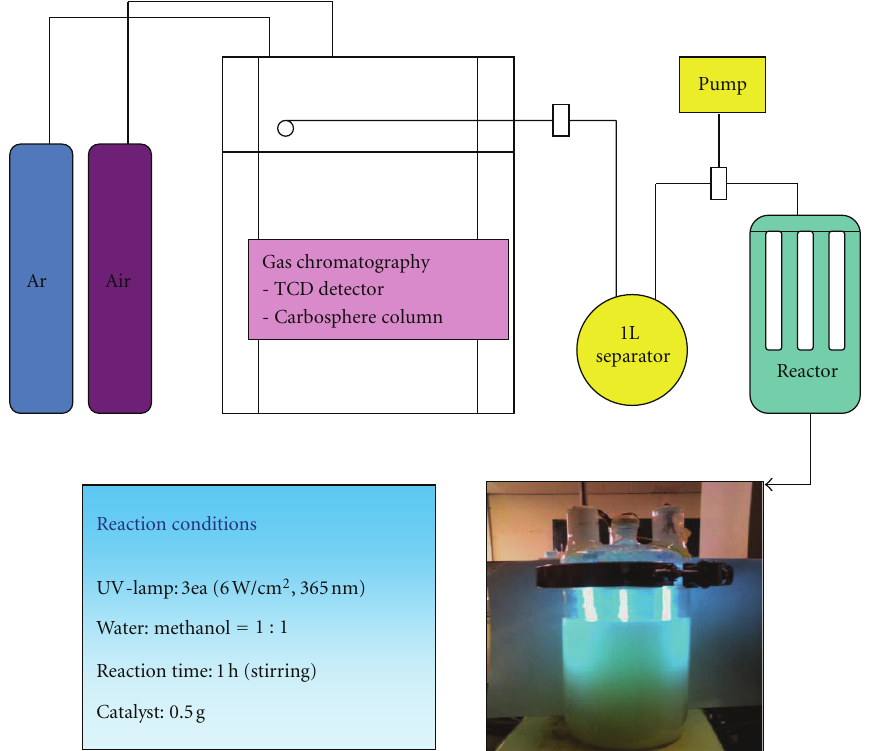
Figure 2: The liquid photoreactor used for H 2 production via methanol/water photodecomposition. Reaction conditions: volumetric ratio of CH 3 OH/H 2 O = 1; catalyst weight per 2.0 L solution, 0.5 g; UV intensity at 365 nm, 18 W m − 2 ; batch system.